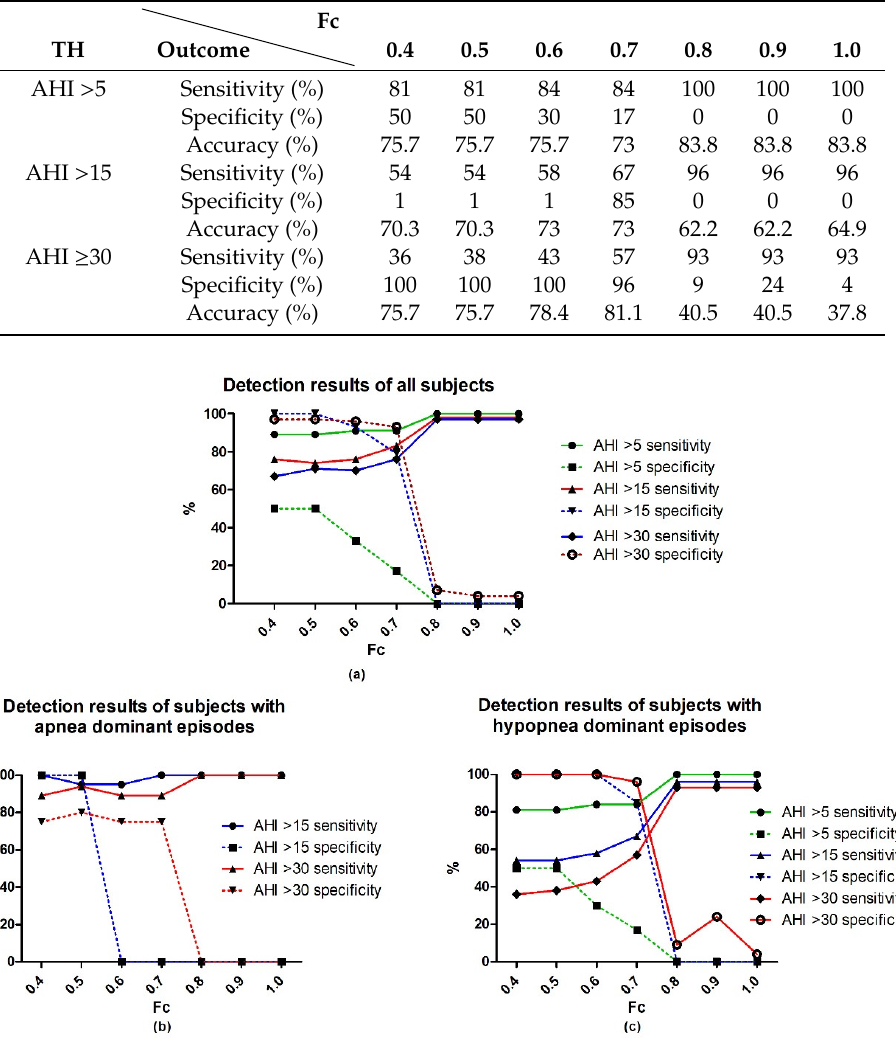
Figure 4. Detection results of all subjects by sensitivity and specificity plots listed as: ( a ) description of overall performance of all subjects; ( b ) description detection performance of subjects with apnea- dominant episodes; ( c ) description detection performance of subjects with hypopnea-dominant